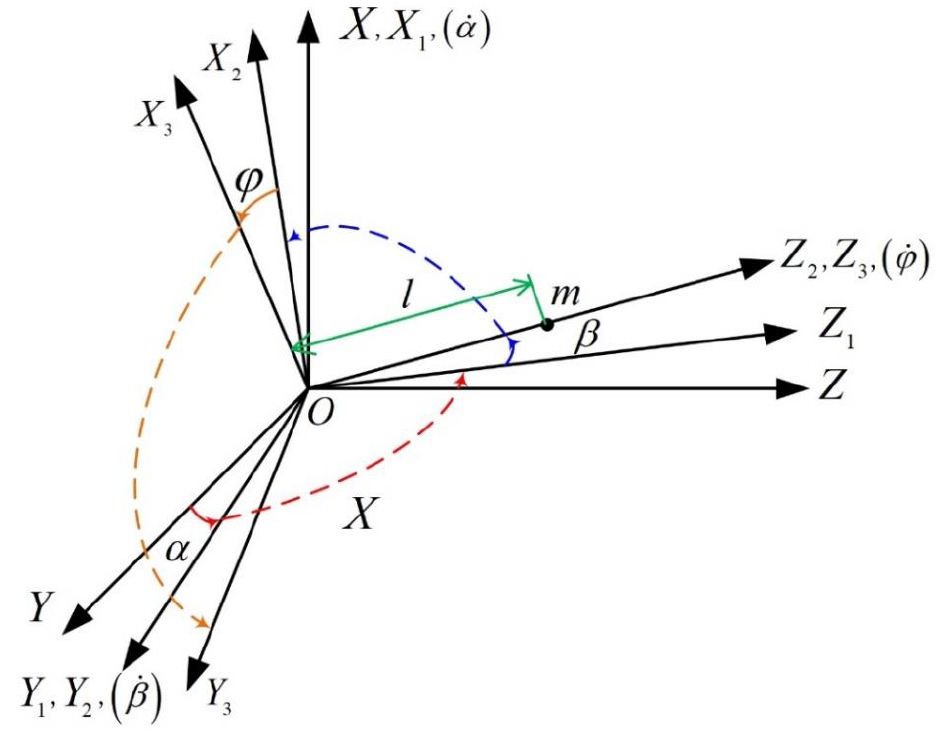
Figure 3. Established coordinates for kinematics and dynamics analyses of PIGA.